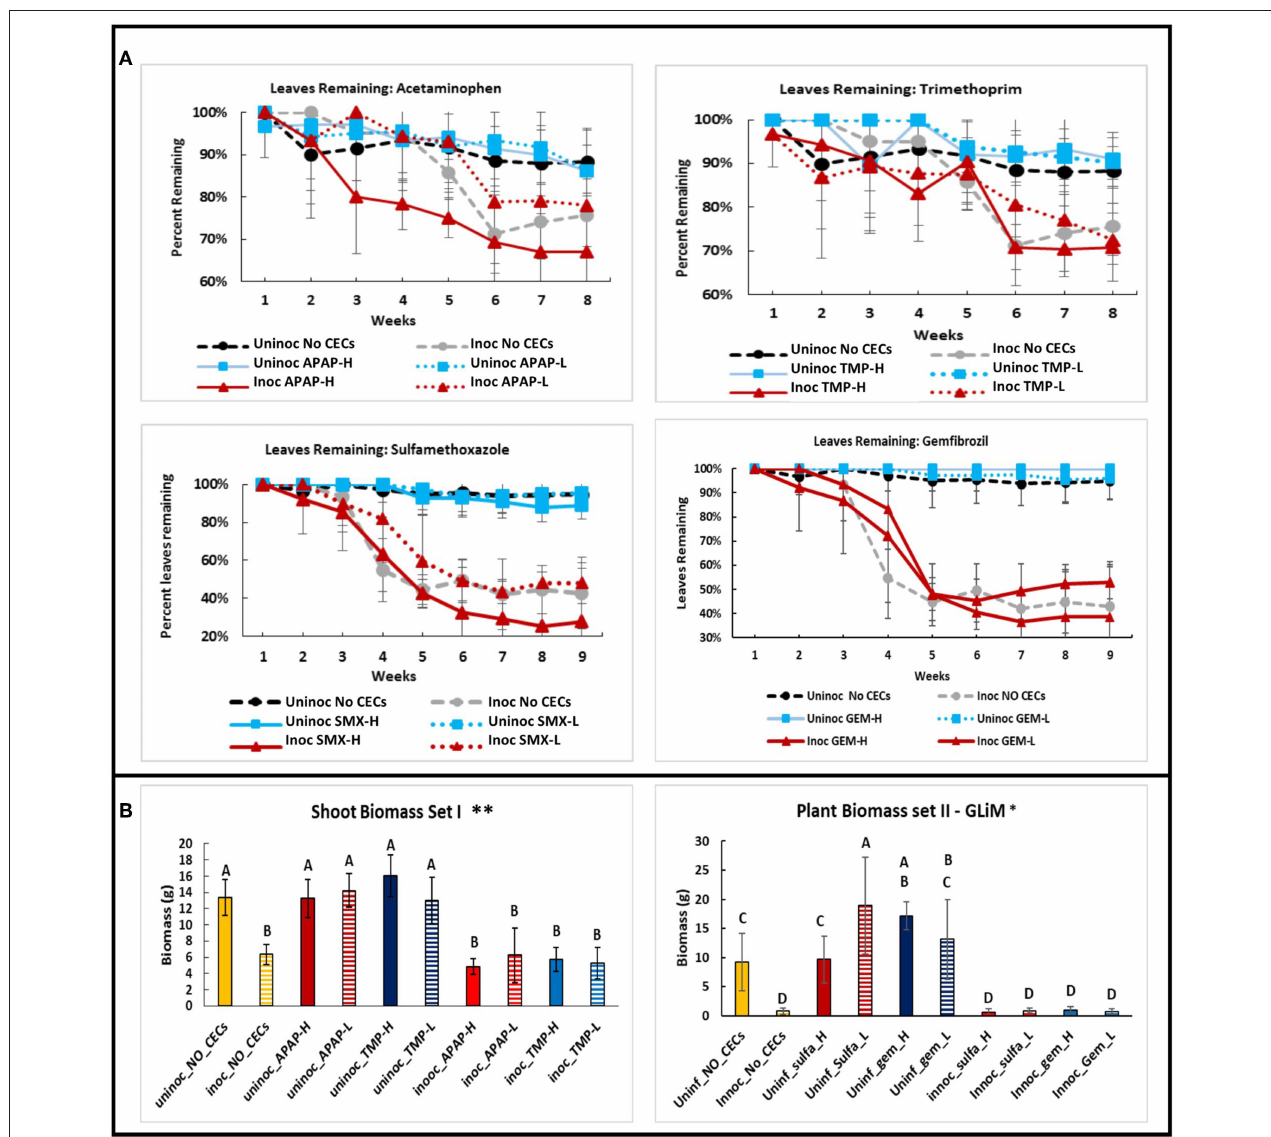
FIGURE 5 | Comparisons of plant health metrics of eggplants grown in the green house among different chemicals of emerging concern (CECs) treatments. (A) Line graphs of leaves remaining on plants over time for each CEC. (B) Above ground biomass of both sets of eggplants at the end of the experiment. The CECs used were acetaminophen (APAP), trimethoprim (TMP), sulfamethoxazole (SMX) and gemfibrozil (GEM). For each CEC two concentrations were used high (H) and low (L). * Samples compared statistically using GLiM with normal distribution and identity link function, pairwise analyses with sequential Bonferroni pairwise correction for multiple comparisons ( P < 0.05). **ANOVA used for statistical analyses, post-hoc Tukey test used for pairwise analyses ( P <